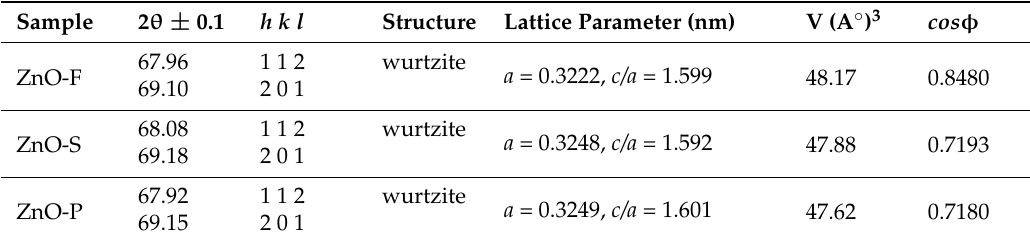
Table 1. The lattice parameters of the synthesized ZnO-NPs.